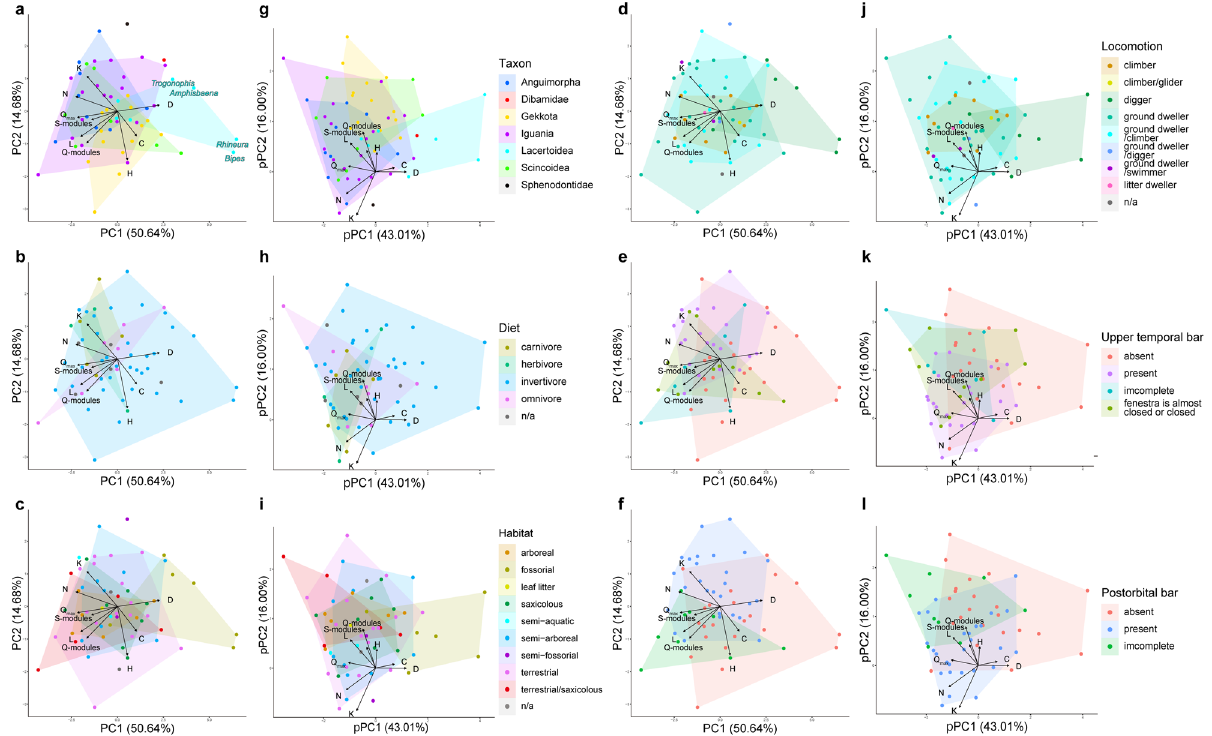
Figure 2. Results of principal component analysis (PCA) and phylogenetic principal component analysis (pPCA). PCA plots colored by ( a ) taxon, ( b ) diet, ( c ) habitat, ( d ) locomotion, ( e ) presence of upper temporal bar and ( f ) presence of postorbital bar. pPCA plots colored by ( g ) taxon, ( h ) diet, ( i ) habitat, ( j ) locomotion, ( k ) presence of upper temporal bar and ( l ) presence of postorbital